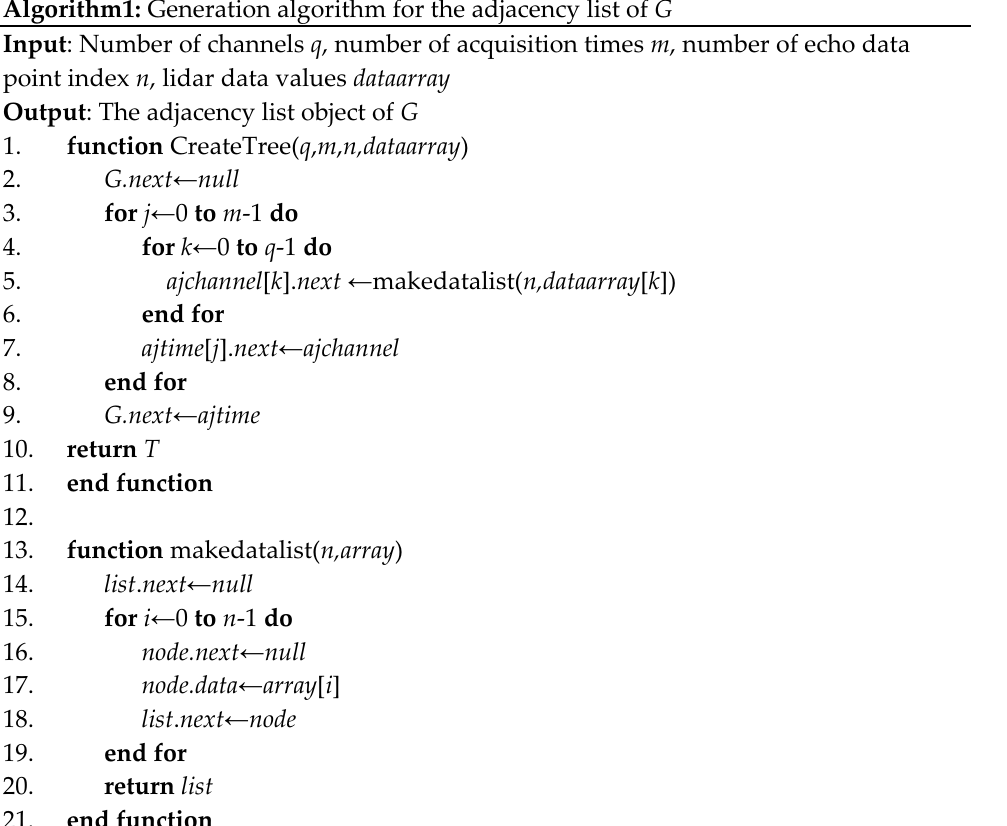
Algorithm1: Generation algorithm for the adjacency list of